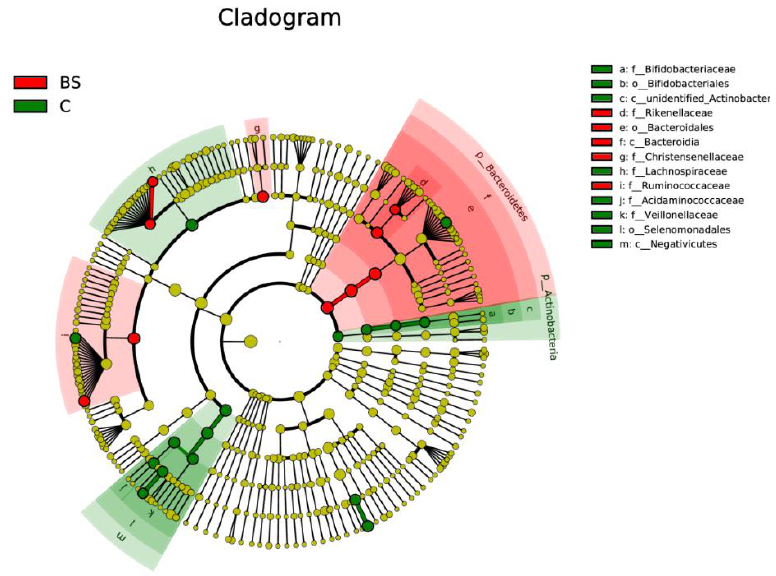
Figure 6. Taxonomic cladogram reporting the different taxon abundances among GIT groups.